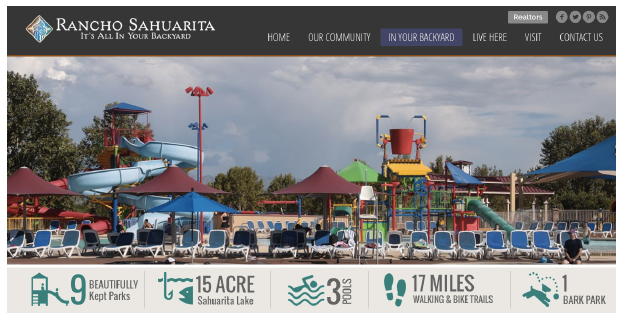
Fig. 2 . Rancho Saguarita, Arizona. Example of a large